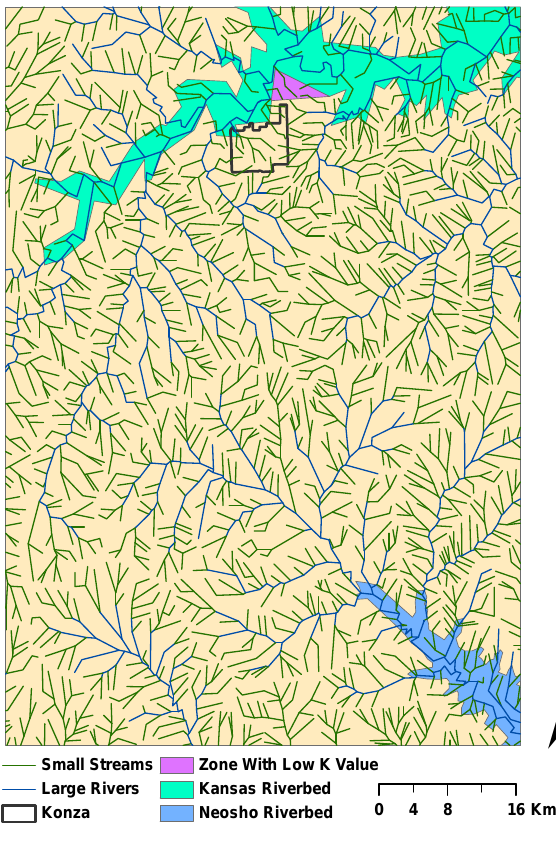
Table 1. Grassland prairie model parameters.